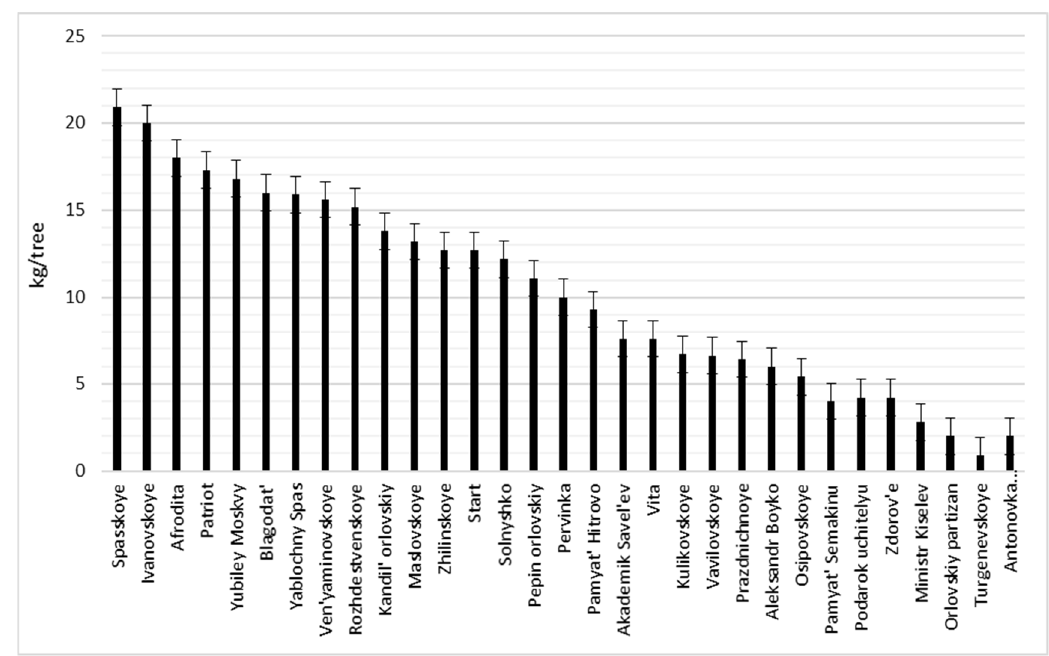
Figure 2. Average yield of the cultivars for 2019–2021 (LSD 05 = 10.4).